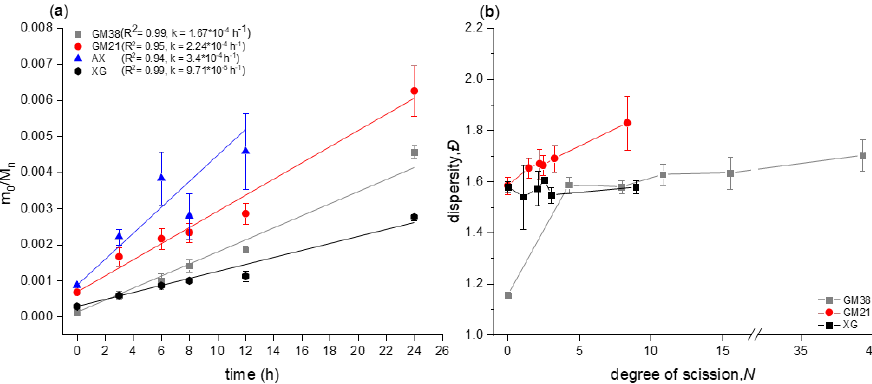
Figure 2. ( a ) Degradation kinetics of the chain backbone of polysaccharides during acid hydrolysis. Galactomannan (GM38 and GM21) and arabinoxylan (AX), 0.1 M HCl at 50 °C. Xyloglucan (XG), 0.4 M HCl at 50 °C. ( b ): Dispersity ( Đ = M w / M n ) as function of the degree of scission N , namely the average number of glycosidic bonds cleaved per polymer molecule (AX data not shown due to analytical artefacts (see text)).